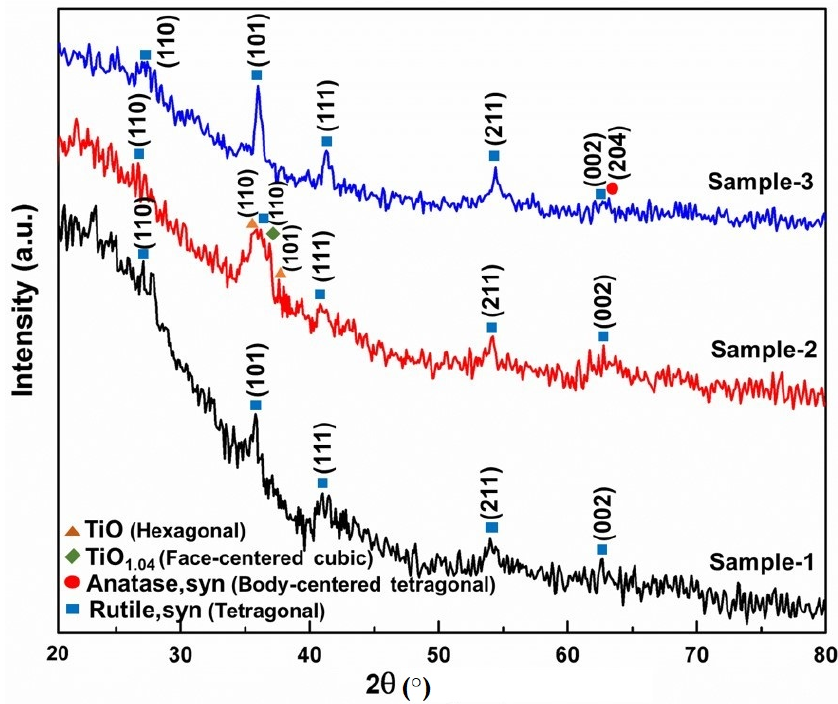
Figure 2. Thin-film X-ray diffraction patterns with different sputtering process parameters thermally oxidized at 450 °C.